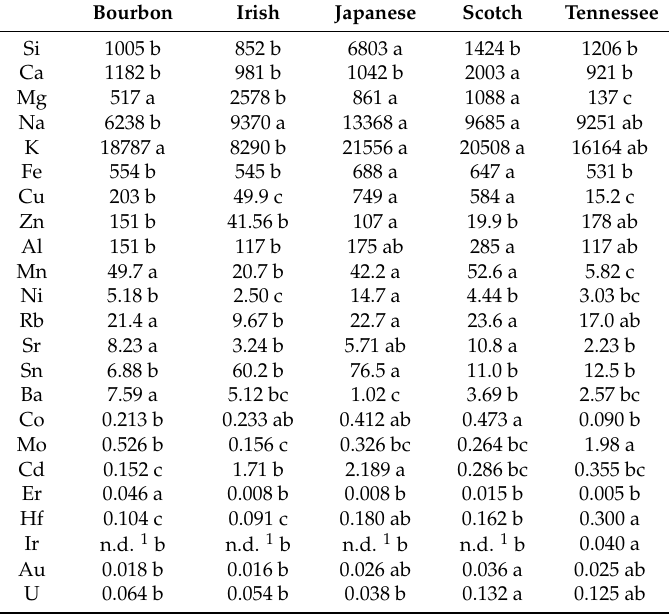
Table 3. Means of 23 elements in µ g/L that differed between whiskey types. Same letter in rows did not differ significantly in the pairwise comparison (Fisher’s LSD, p <